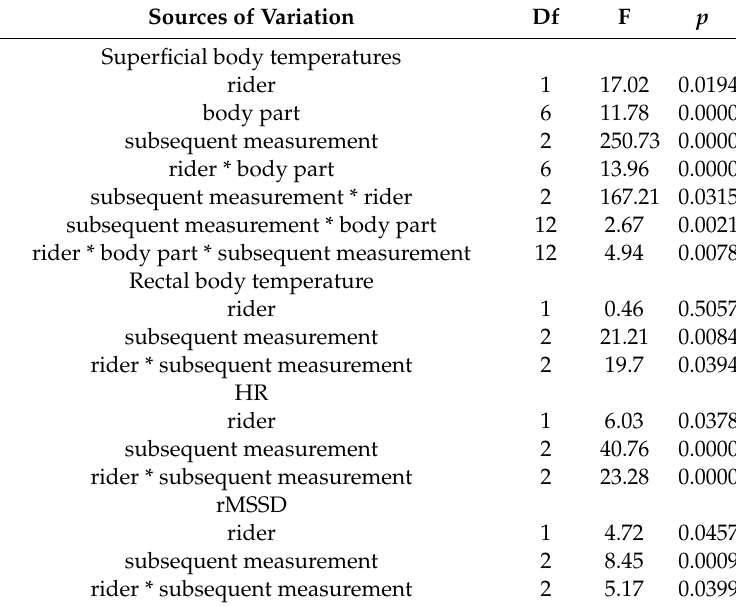
Table 3. Sources of variation.